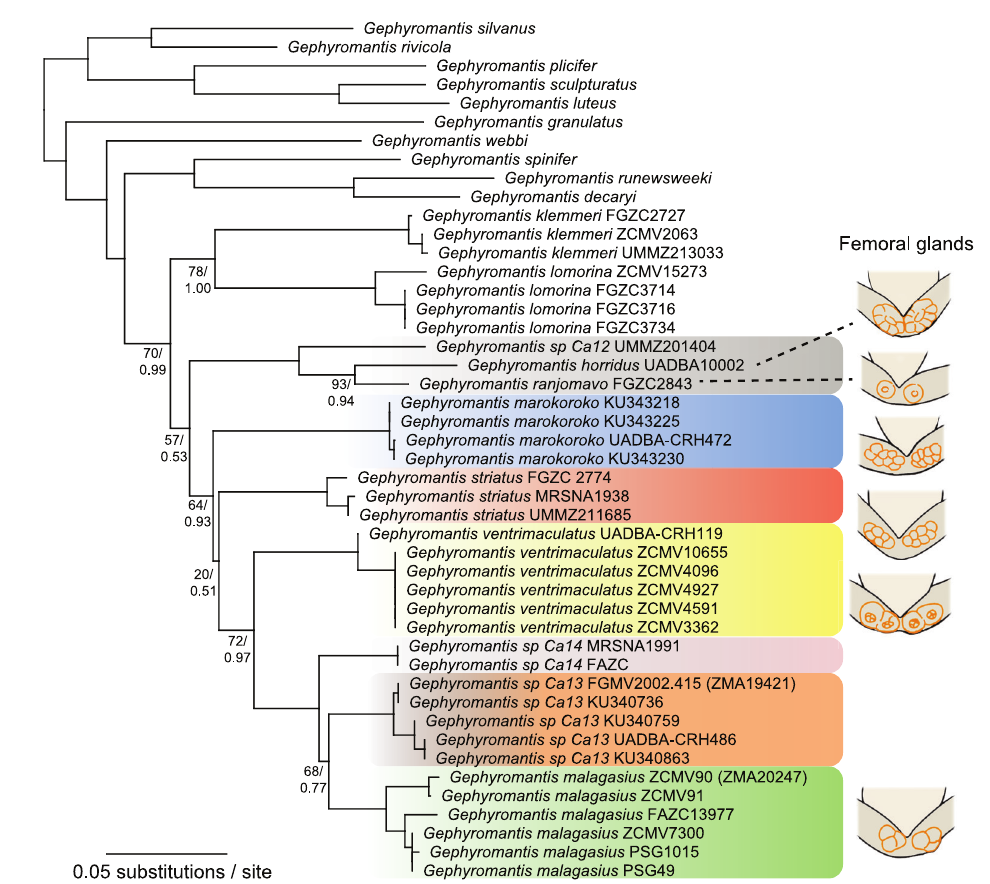
Figure 3. Results of phylogenetic analysis of the mitochondrial 16S rRNA barcode 3’ marker for Maximum Likelihood (ML) and Bayesian Inference (BI). Topology is a consensus tree from IQ-Tree. The support values are shown as Bootstrap on top and Posterior Probability on the bottom only for nodes that were not perfectly supported. Note that Gephyromantis marokoroko sp. nov. placement in the clade is weakly supported in both analyses. Table 1. Comparison of distinguishing characters used to differentiate species within Laurentomantis . Table adapted from Vences et al. (2002) combined with new data. Genetic distances are uncorrected and taken from the 16S rRNA mitochondrial